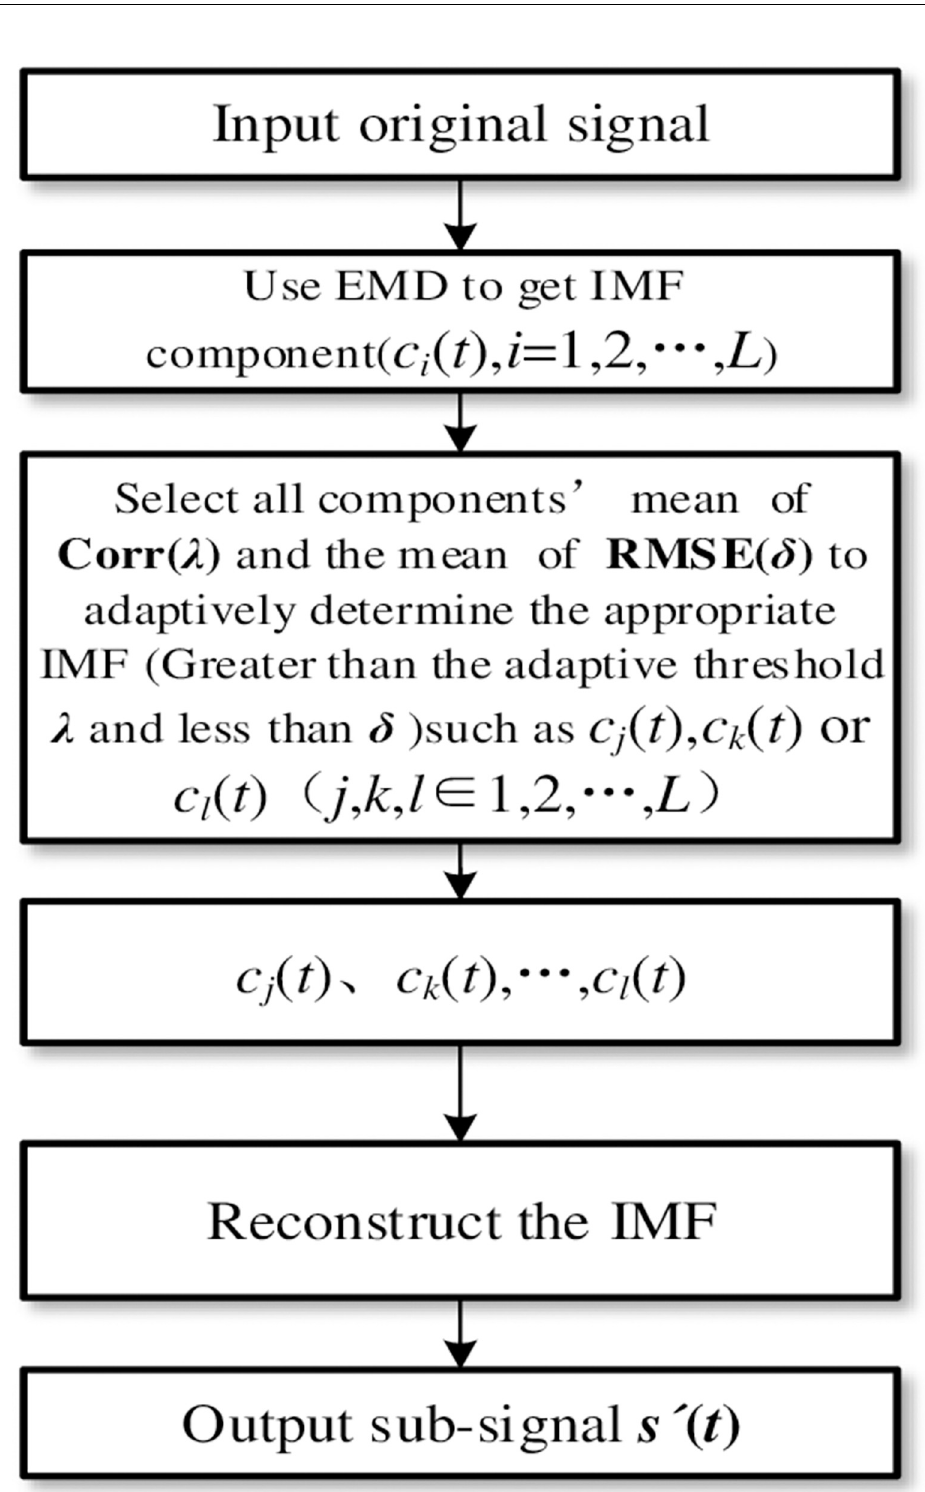
Fig 4. The flowchart based on EMD with adaptive reconstruction.